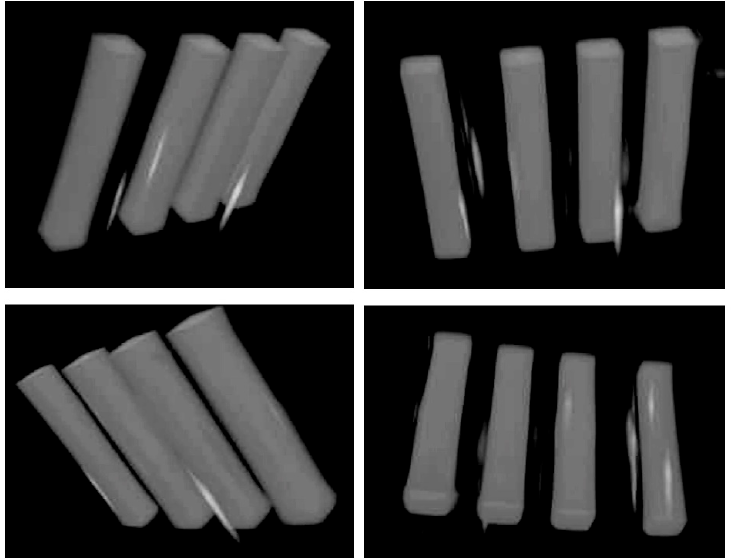
Figure 18. Still frames from the 3D video reconstructed from 20 tomographic images taken of the irradiated gel along the axis of the beams. The bright areas are related to spurious fluorescent dust particles in the gel.